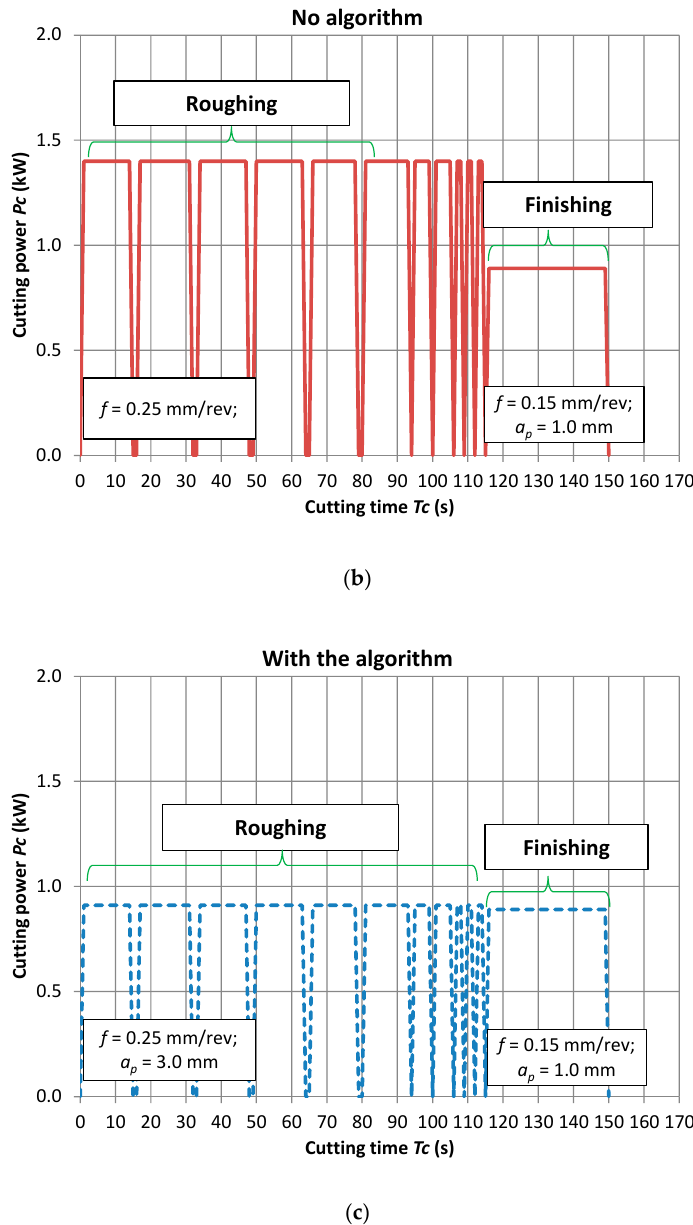
Figure 13. Example illustrating the operation of the machining optimization algorithm ( a ) view of parts and machining paths, ( b ) power demand course during cutting time ( Tc ) without the algorithm, ( c ) power demand course during cutting time ( Tc ) with the algorithm used.